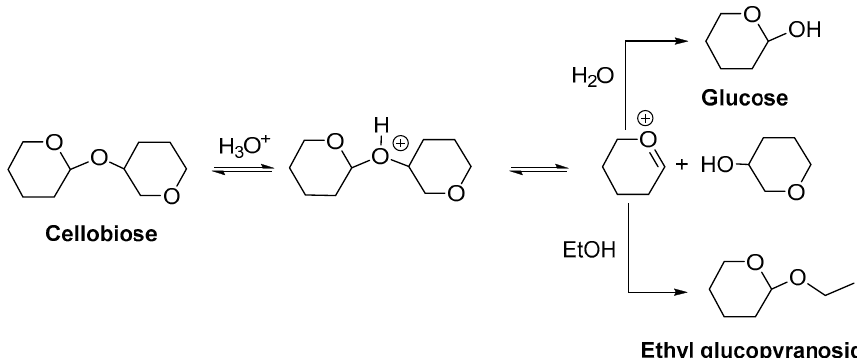
Figure 5. Mechanism of acid hydrolysis of glycosidic bonds in water or organic medium (hydroxyl groups have been voluntary omitted for more clarity).